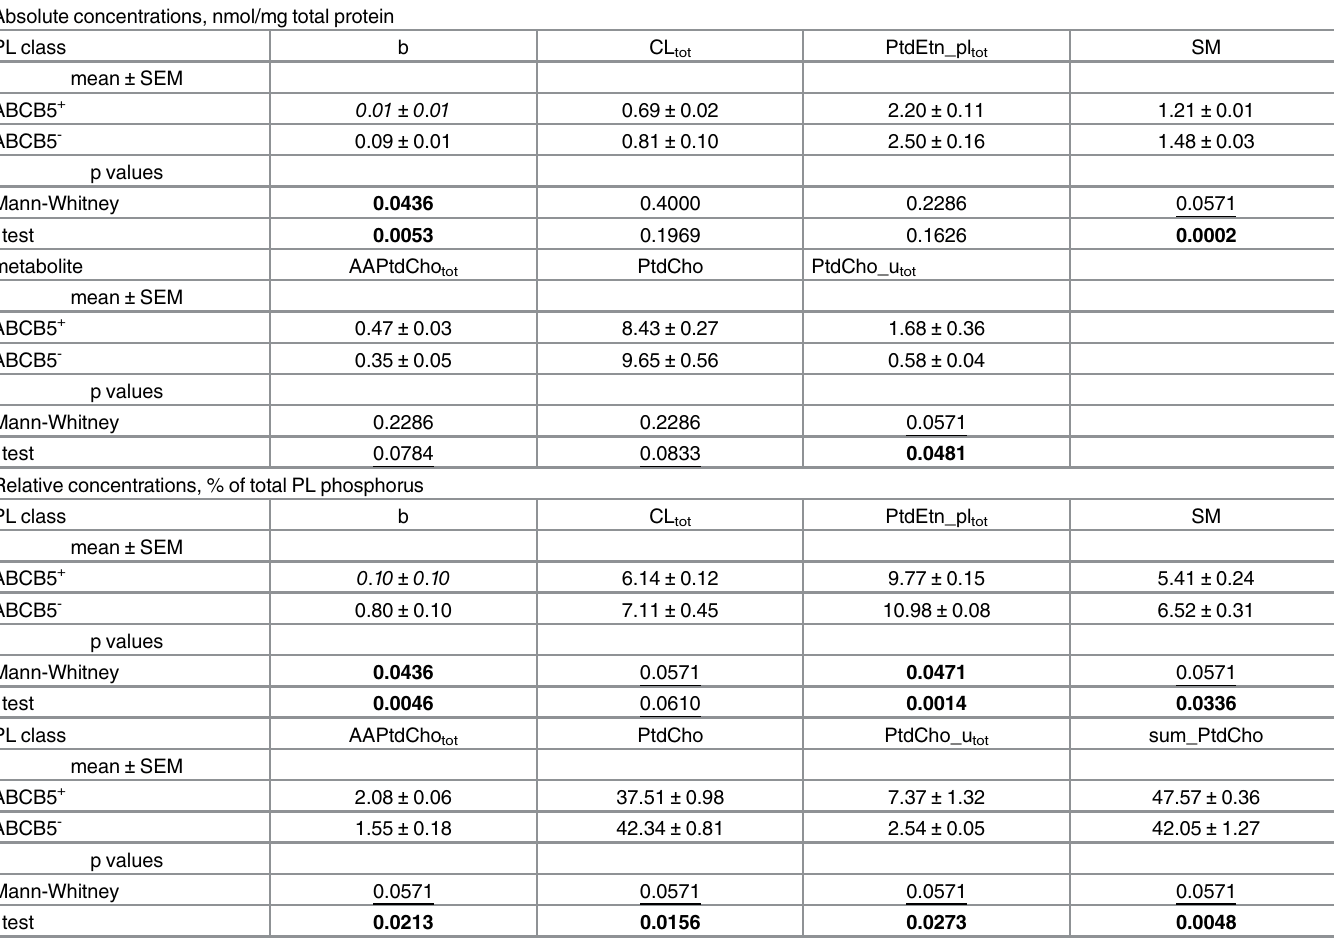
Table 3. Significant differences between phospholipid levels in ABCB5-WT and ABCB5-KD G3361 melanoma